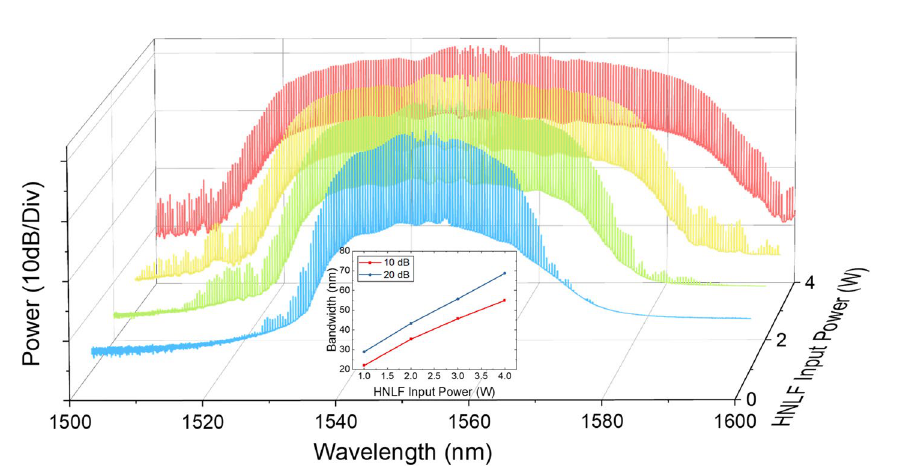
Figure 6. Experimentally measured optical spectrum of the bandwidth programmable supercontinuum, and inset shows 10 dB and 20 dB bandwidth according for HNLF input